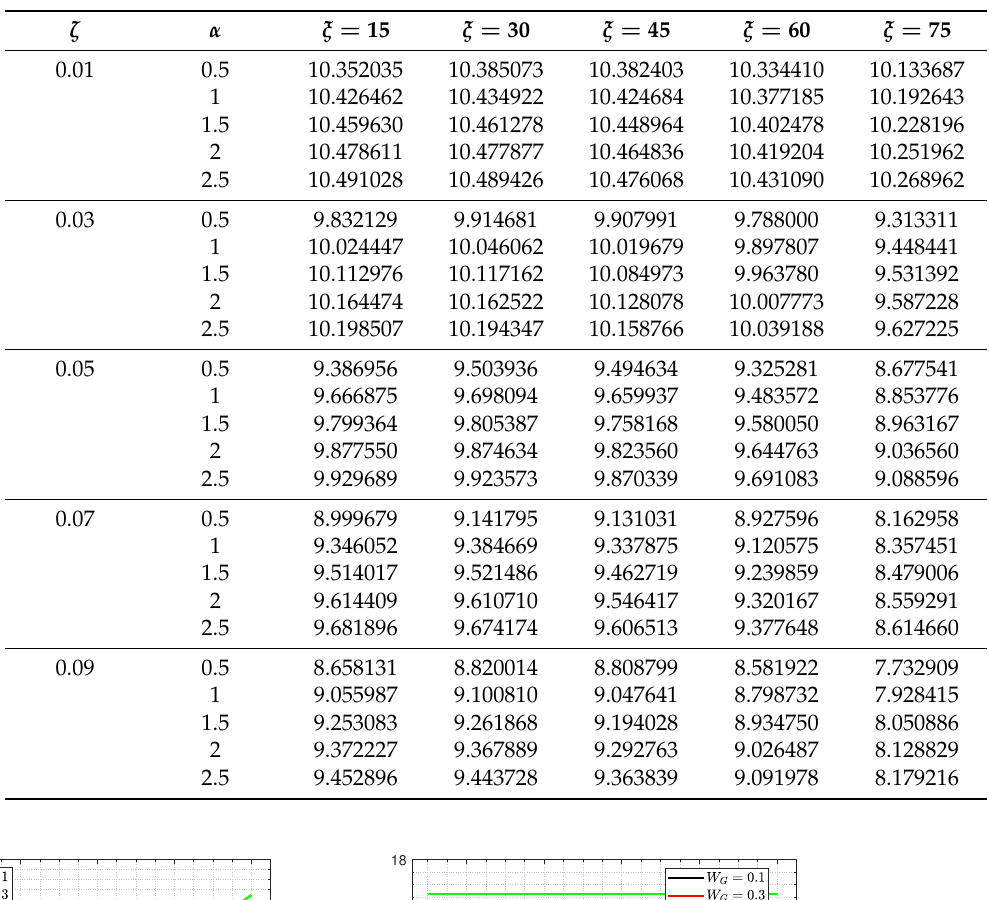
Table 3. Effects of various values of the honeycomb’s cell dimensions ζ , α and ξ on the wave frequency ¯ ω (THz) of GPLs-reinforced sandwich piezoelectromagnetic plate.